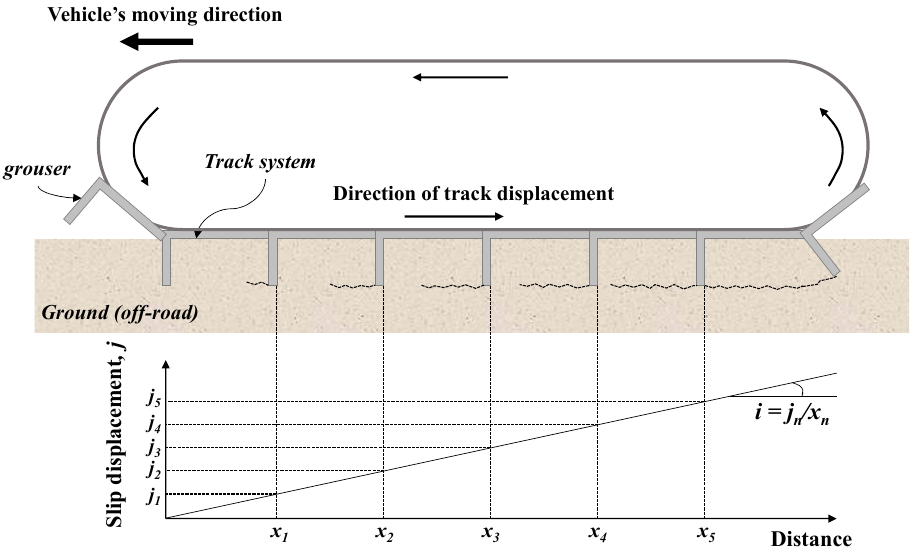
Figure 2. Schematic diagram of slip displacement on the soil-track interface.